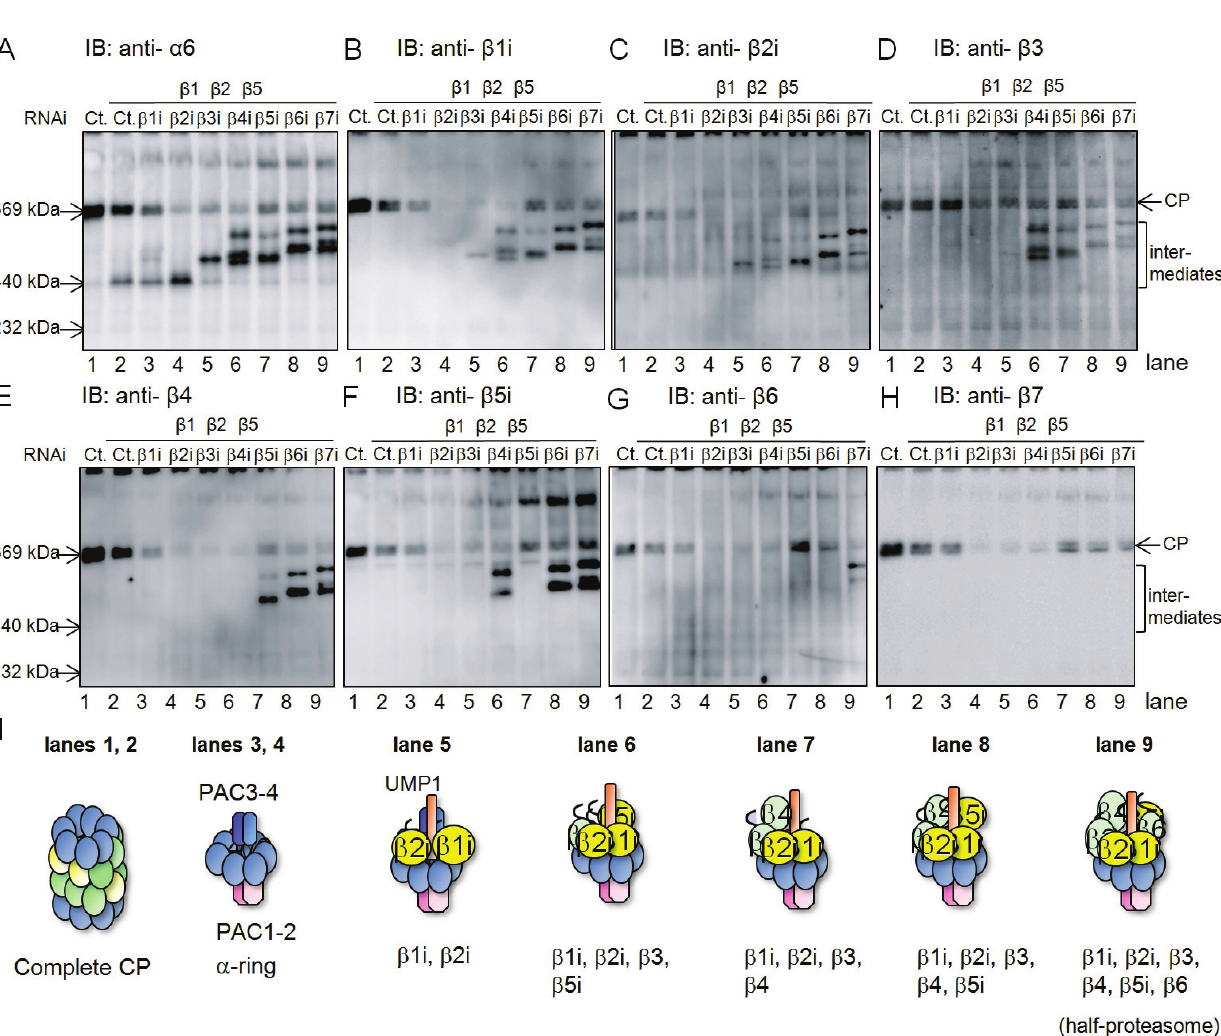
associated forms, which appeared as doublets in lanes of (cid:2)5i and (cid:2)7 RNAi for unknown reason, and the slower migrating bands were PA28 associated forms (Figure 2E,G,H). Figure 1. Analysis of the accumulated intermediates in each (cid:2)-subunit knockdown cells of the immunoproteasome. ( A ) HeLa cells were treated with IFN-(cid:4) to induce (cid:2)1i, (cid:2)2i, and (cid:2)5i. By employing siRNA targeting (cid:2)1, (cid:2)2, and (cid:2)5, the expression of catalytic subunits of the standard proteasome were suppressed. Knockdown of (cid:2)1i, (cid:2)2i, (cid:2)3, (cid:2)4, (cid:2)5i, (cid:2)6, and (cid:2)7 was performed to induce accumulation of intermediates. The cell extracts (20 (cid:5)g) were then separated by native PAGE, followed by immunoblot analysis using anti-(cid:3)6 antibody; ( B – H ) The same panel of Figure 1A was immunoblotted with anti-(cid:2)1i ( B ); anti-(cid:2)2i ( C ); anti-(cid:2)3 ( D ); anti-(cid:2)4 ( E ); anti-(cid:2)5i ( F ); anti-(cid:2)6 ( G ); and anti-(cid:2)7 ( H ) antibodies; ( I ) Schemes of CP and CP precursors in lanes 1 – 9 of ( A – H ).